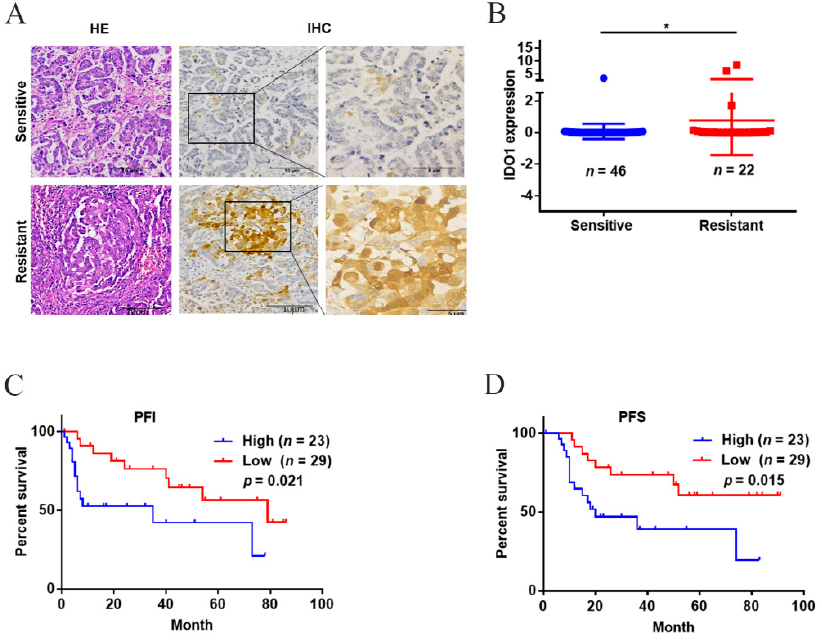
Figure 1. The expression level of IDO1 and the prognosis in patients with ovarian cancer. ( A ) Repre- sentative images of IDO1 staining in cancer tissues; the scale bar was 100 µ m. ( B ) The IDO1 expression level. ( C , D ) Kaplan–Meier plots of PFI and PFS in patients with type II ovarian cancer. Data were mean ± standard deviation. *: p < 0.05.